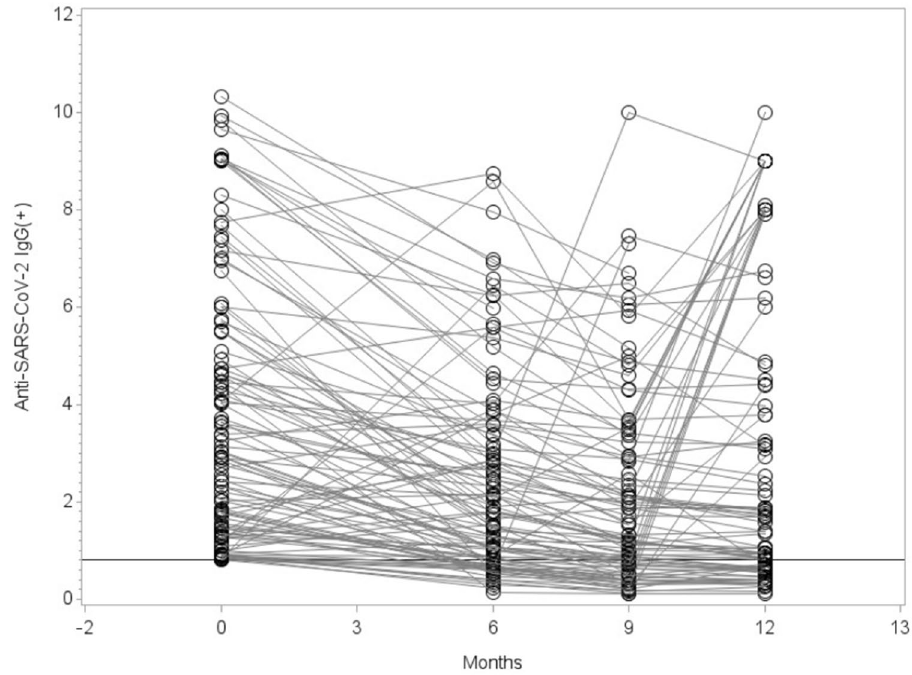
Figure 5. IgG levels over time of participants who were IgG(+) at baseline and participated at least in one of the three follow-up visits (6, 9, and 12 months after our previous study in April 2020 21 ) were analyzed. Time point 0 months refers to the published data values of the original study. 27 participants who developed IgG values below the ratio of 0.8 (Limit of Quantification) were considered as seroreversed. Statistical significance was assessed using Wilcoxon sign-rank test and the resulting six p-values were adjusted for multiple testing following the Bonferroni-Holm procedure. Visit 1 vs. 0: p < 0.0001; Visit 2 vs. 0: p < 0.0001; Visit 3 vs. 0: p = 0.0016; Visit 1 vs. 2: p < 0.0001; Visit 1 vs. 3: p = 0.0053; Visit 2 vs. 3: p < 0.0001. All comparisons show a decreasing trend with time. It is important to note, that although the graph only shows those with IgG ratio ≥ 0.8 at visit 0, all subjects who contribute data for visit 0 and at least one of the following visits are included in the test (without restriction at visit 0). In addition, we excluded IgG values from participants who had received at least one dose of SARS-CoV-2 vaccine (Visit 2: n = 15, Visit 3: n = 46). This is because the ELISA we used is specific for SARS-CoV-2 spike protein, making it impossible to distinguish between an IgG response to natural infection or